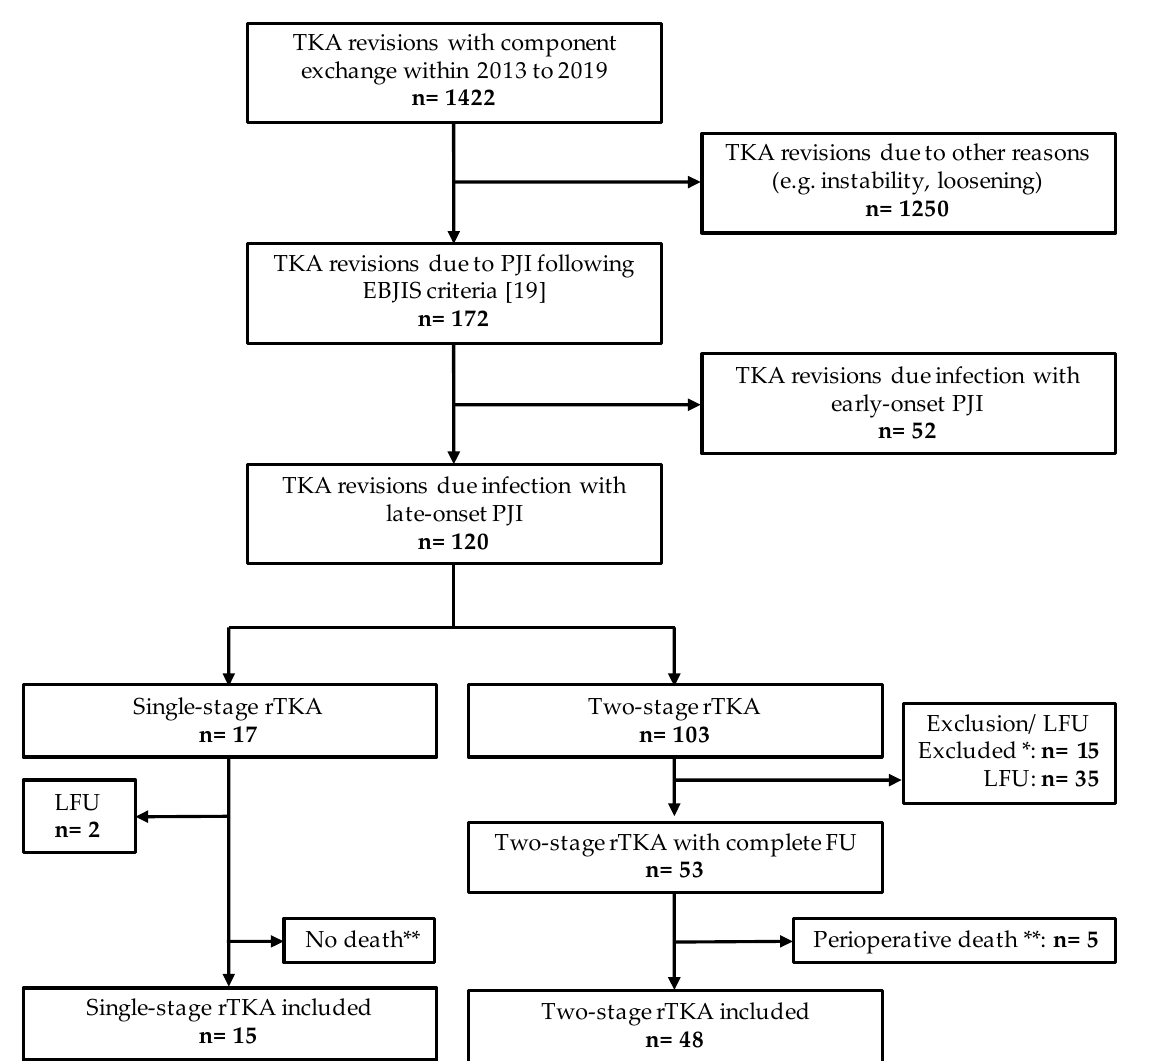
Figure 1. Study flow diagram: TKA, total knee arthroplasty; rTKA, revision TKA; PJI, periprosthetic joint infection; EBJIS, European Bone and Joint Infection Society; LFU, lost to follow-up; FU, follow-up; *, patients did not meet inclusion criteria due to incomplete data for PJI evaluation, e.g., inadequate number of intraoperative tissue samples for microbiological analysis; **, died in the course of implant removal or reimplantation procedure and analyzed separately.